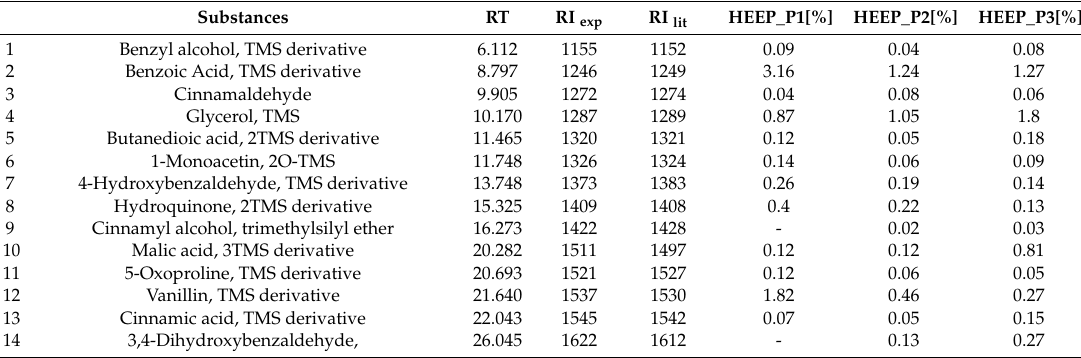
Table A3. GC-MS profile of hexane-ethanol extracts of propolis (HEEP) from di ff erent regions of Poland: HEEP_P1 —Podlasie (Hajnowka), HEEP_P2 —Masovia (Ciechanow), HEEP_P3 —West Pomerania Province